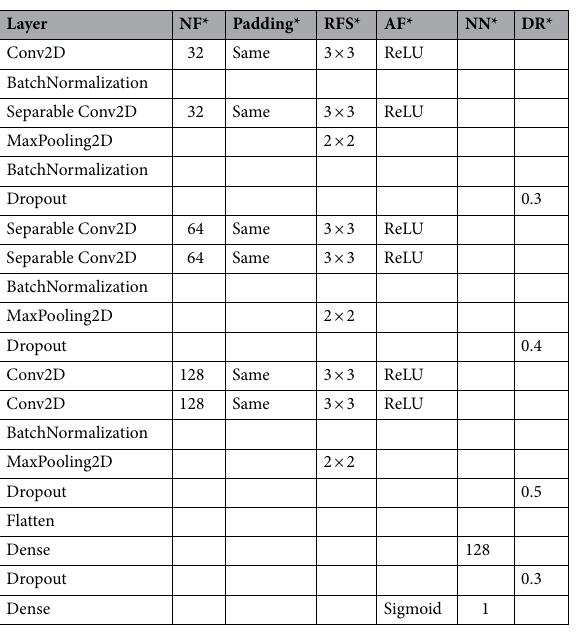
Table 3. The detailed configuration of the proposed DCNN model. * NF number of filters, RFS receptive field size, AF activation function, NN number of neurons, DR dropout rate.